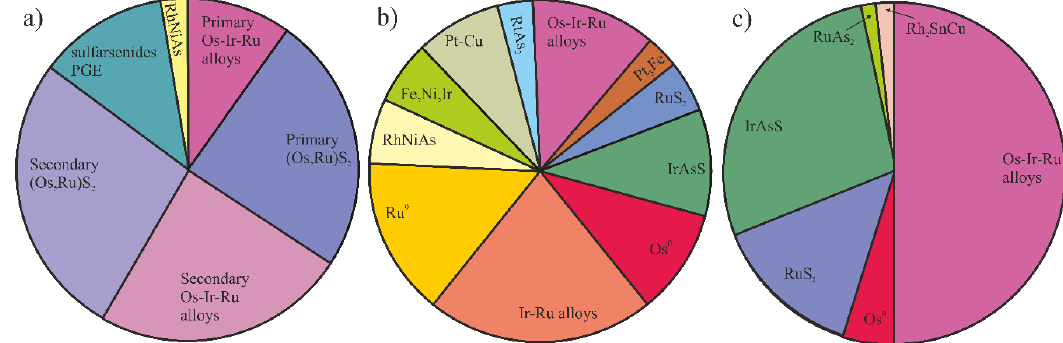
Figure 16. PGE assemblage ( a ) Ulan-Sar’dag chromitites; ( b ) the northern branch of the SEPES ophiolite; ( c ) the southern branch of the SEPES ophiolite [36].